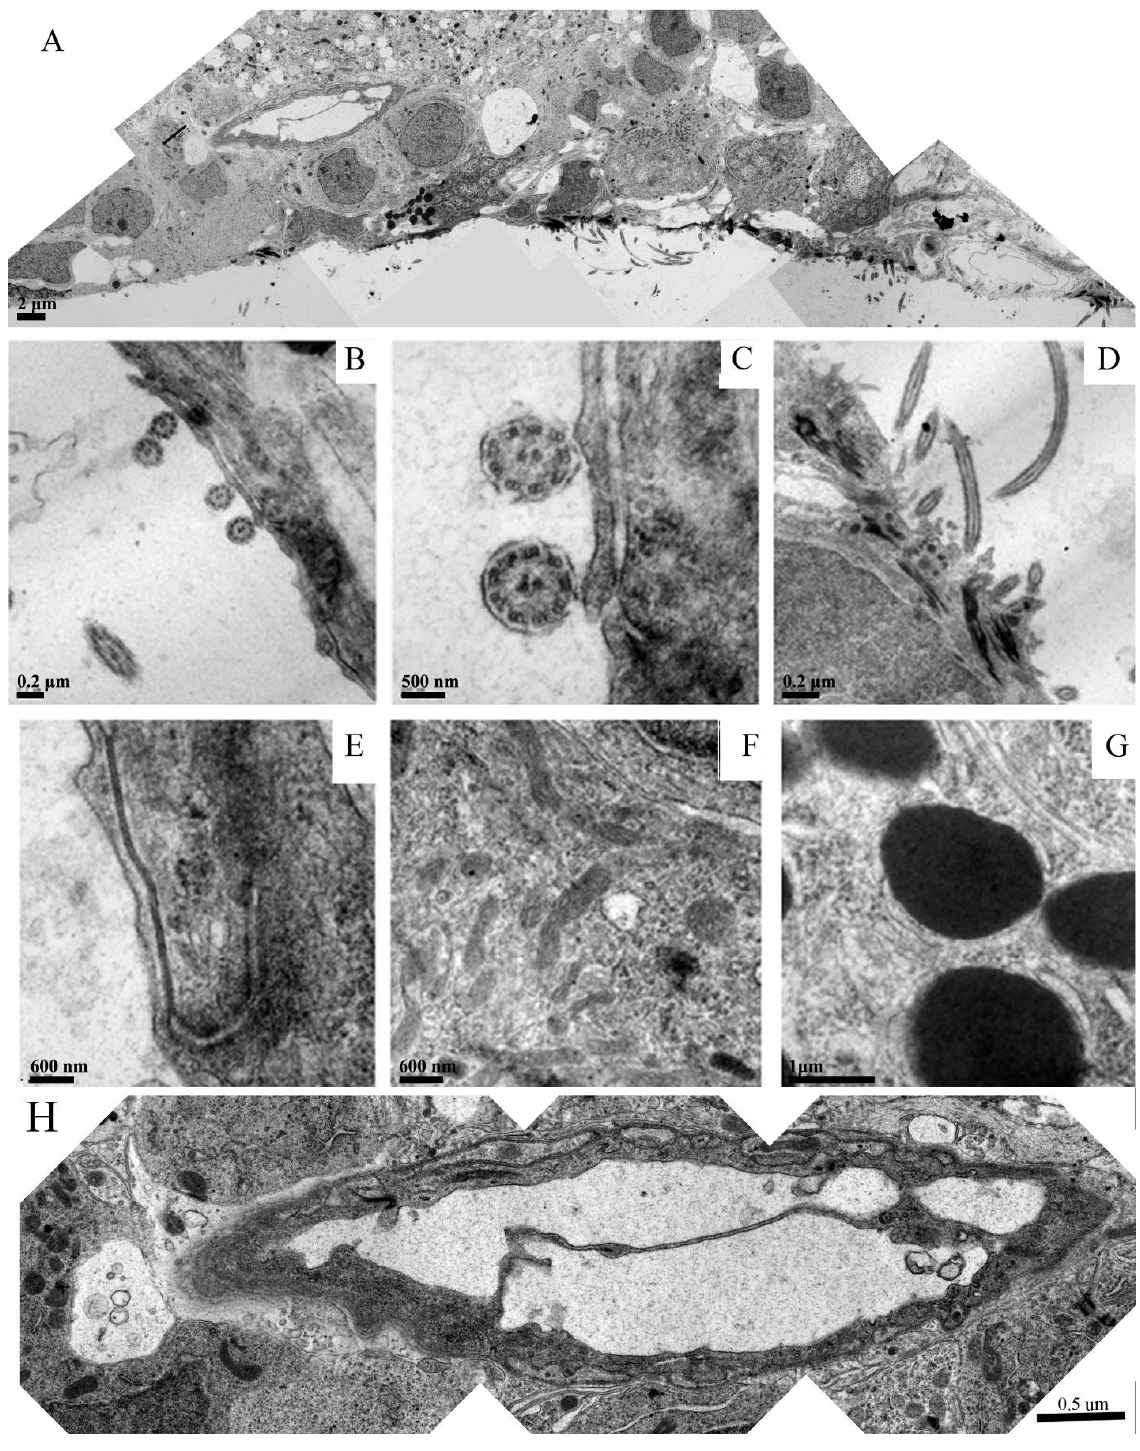
Figure 5. The different regions of the forming ependymal layer in the embryoid embodiment. ( A ) is a montage showing newly formed ependymal cells with their microvilli protruding into the ventricular space. Neovascularization can also be recognized. ( B – D ) depict longitudinal and cross sections of the ependymal microvilli within the neural groove. ( E ) depicts a well-formed tight junction be- tween two neighboring ependymal cells. ( F ) shows that the cytoplasm of these ependymal cells were loaded with healthy mitochondria and other organelles. Some of the forming ependymal cells that were imaged were loaded with dark inclusions, which are shown in ( G ). ( H ) is a montage of the venous blood vessel seen in ( A ) at a higher magnification.